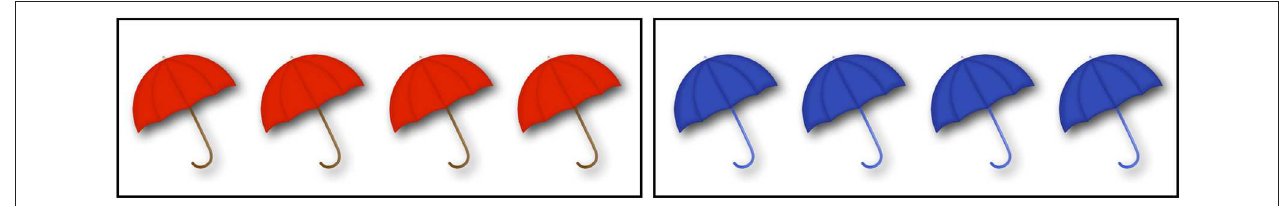
FIGURE 4 | Images corresponding to the plural definite description control condition. When accompanied by the image on the left, in which all four umbrellas are red, the positive and negative descriptions in (13) would be associated with a yes - and a no -target, respectively. When accompanied by the image on the right, in which all four umbrellas are blue, the positive and negative sentences in (13) would be associated with a no - and a yes -target, respectively.